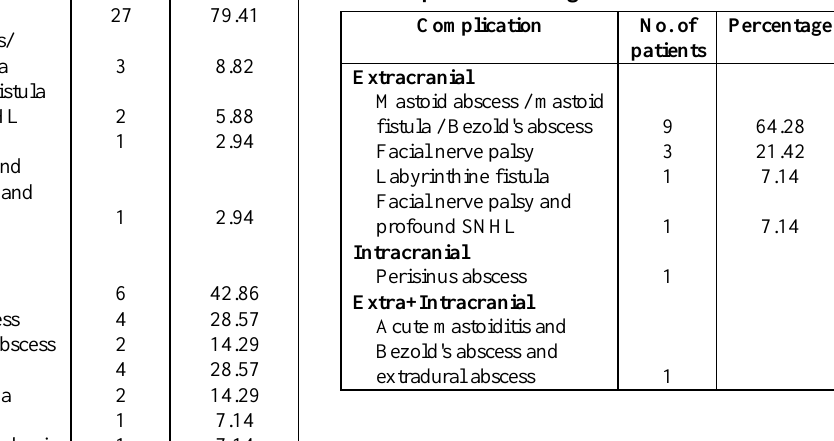
Table VII. Distribution of complications in patients with granulation